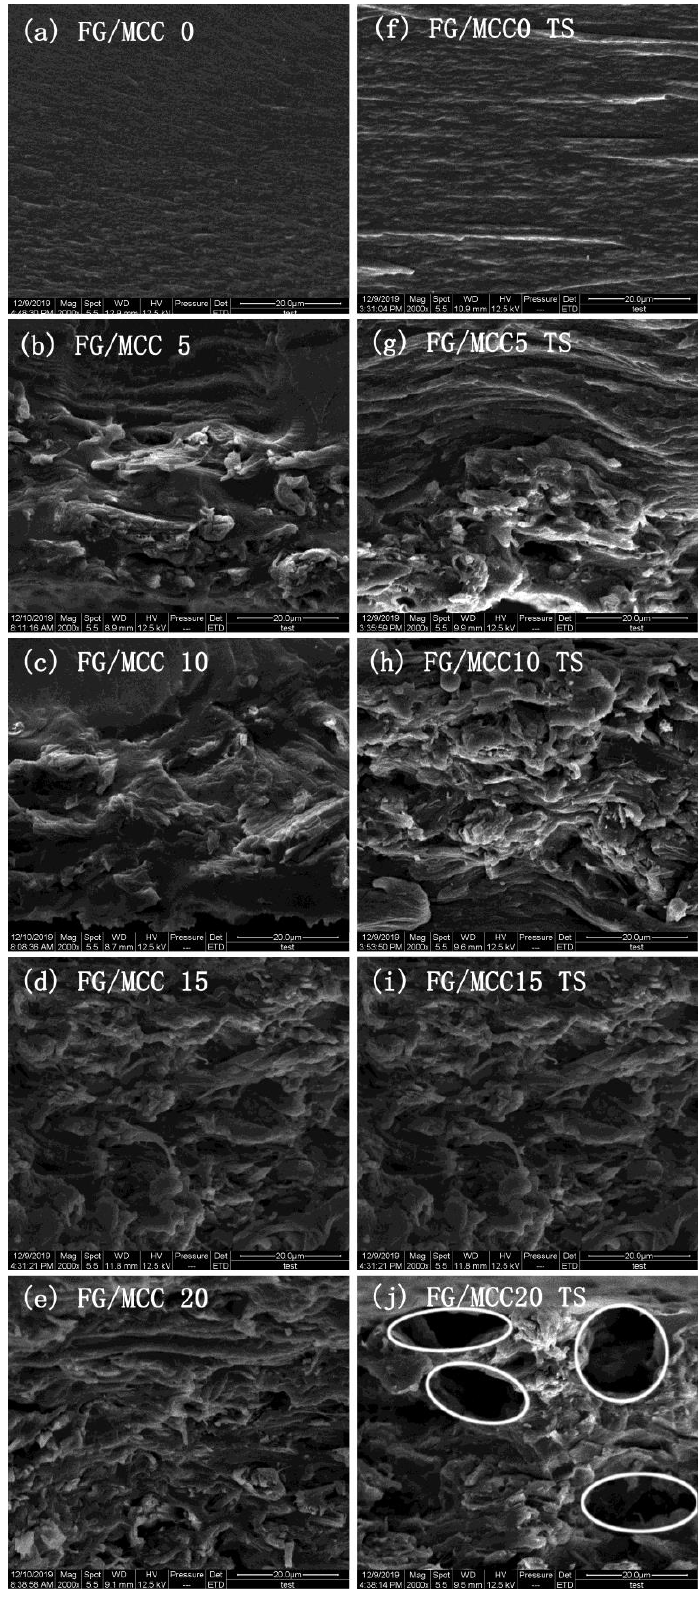
Figure 2. SEM images of the liquid nitrogen brittle section and tensile section (TS) of ( a ) FG/MCC, ( b ) 0 FG/MCC 5, ( c ) FG/MCC 10, ( d ) FG/MCC 15, ( e ) FG/MCC 20, ( f ) FG/MCC 0 TS, ( g ) FG/MCC 5 TS, ( h ) FG/MCC 10, ( i ) TS FG/MCC 15 and ( j ) FG/MCC 20